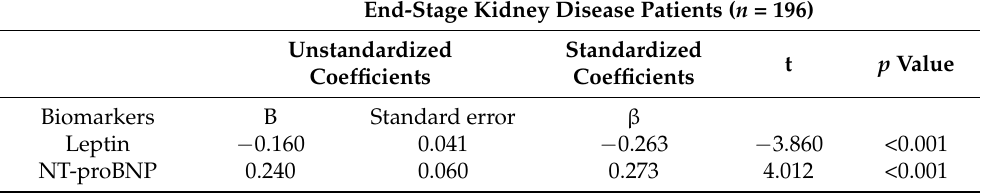
Table 2. Main determinants of left ventricular mass index in end-stage kidney disease, by a multiple regression